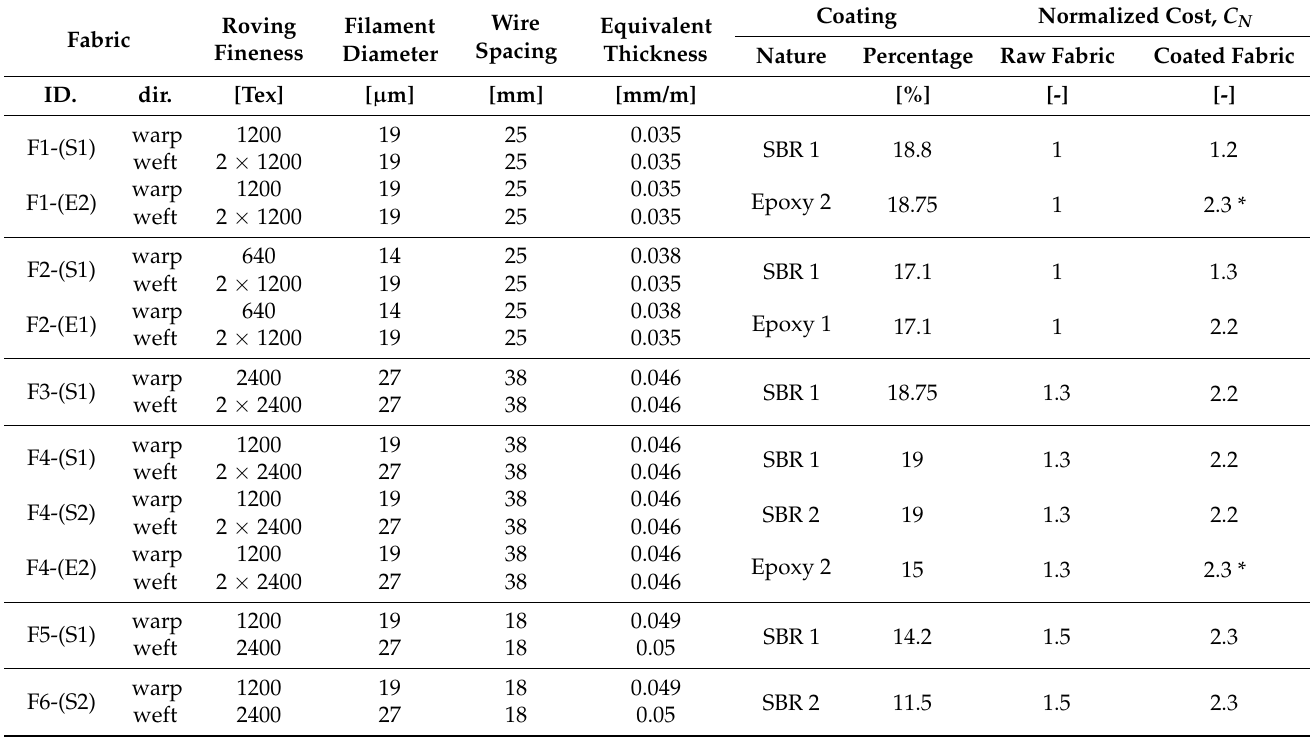
Table 1. AR-glass fabric properties and costs (part 1, equivalent thickness in the warp direction lower than 0.05 mm/m).